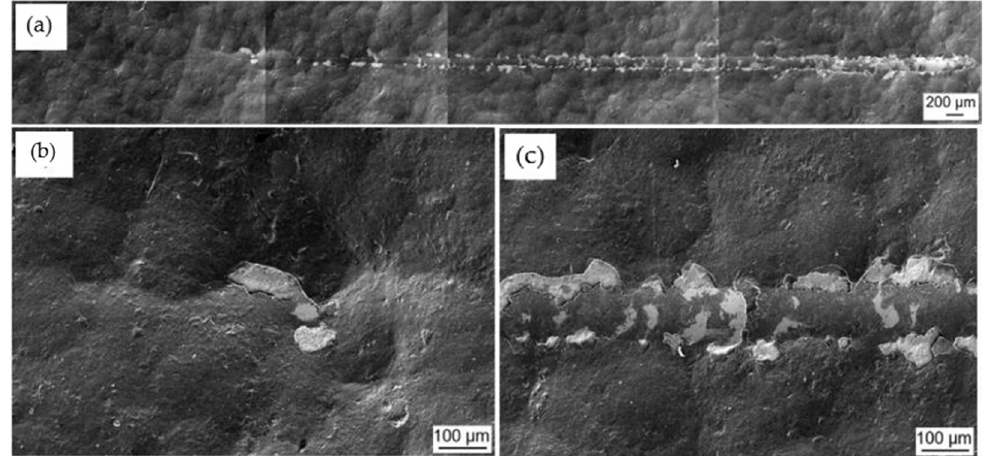
Figure 13. SEM topographical images of the wear scar morphology on the printed and hybrid treated 316L SS: ( a ) Whole length of the wear scar ( b ) Location of L C3 and ( c ) Further delamination along the wear track.